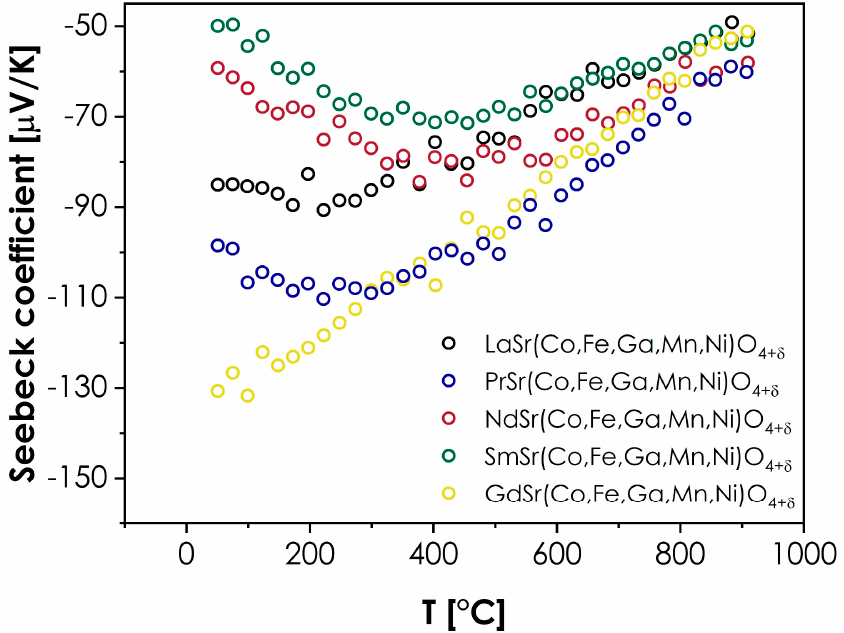
Figure 5. Seebeck coefficient values measured for the LnSr(Co,Fe,Ga,Mn,Ni)O 4+ δ series (Ln = La, Pr, Nd, Sm, or